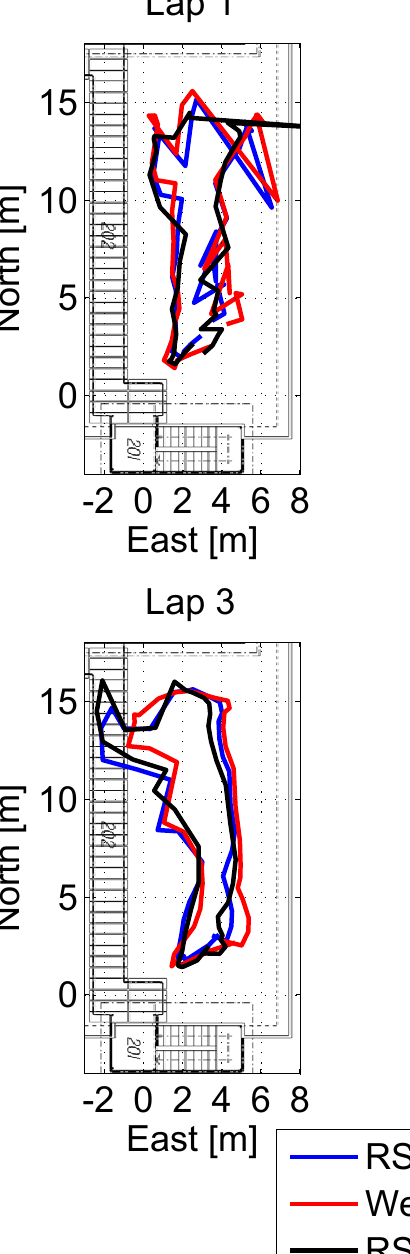
Figure 18. Trajectories obtained considering hybrid approaches for the four laps performed by the